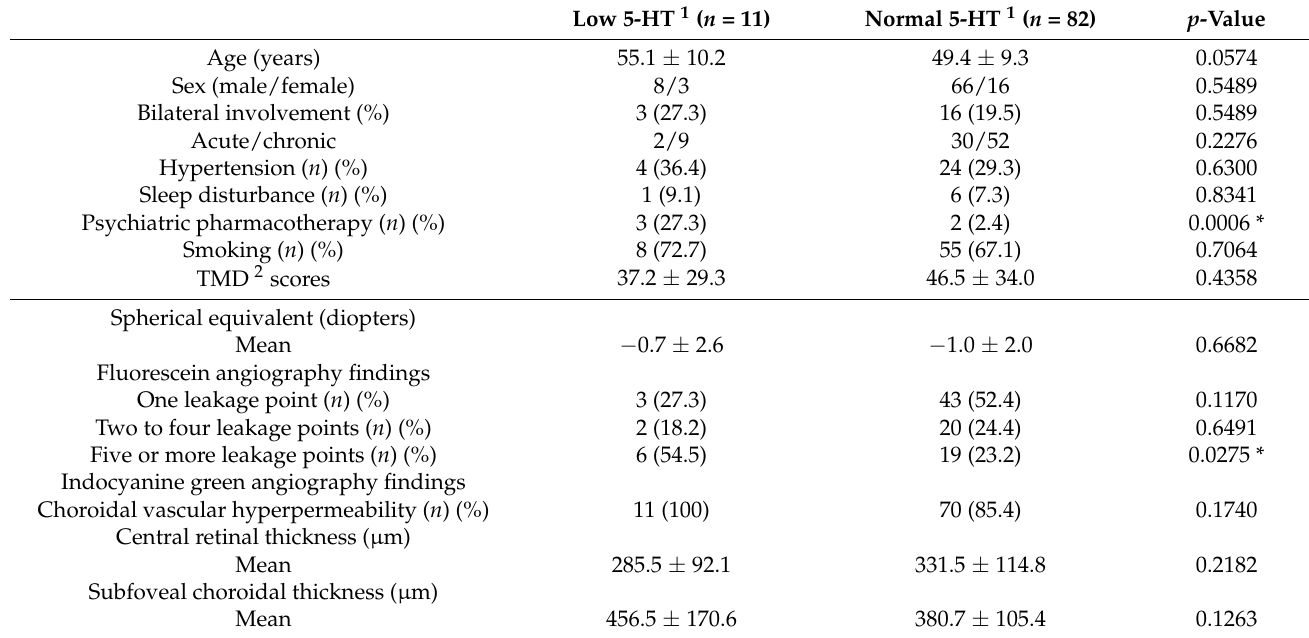
Table 1. Characteristics in the low and normal 5-HT concentrations.